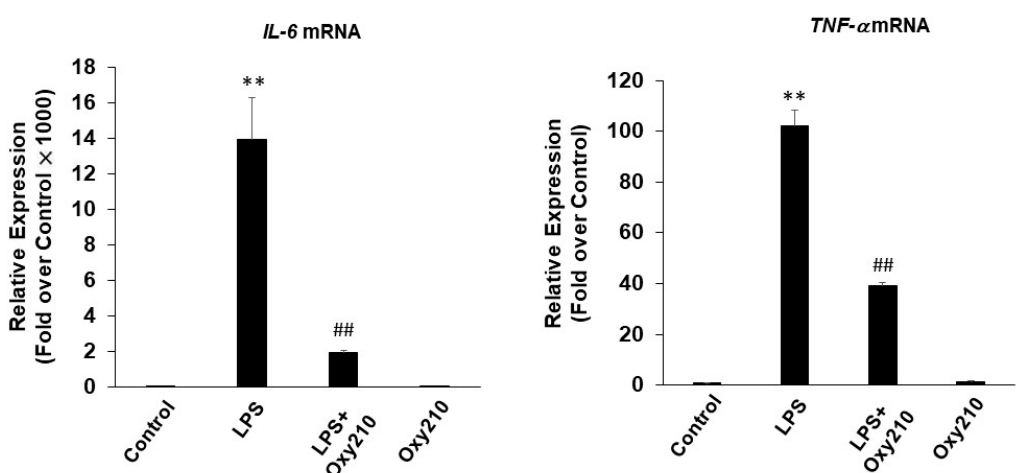
followed by the addition of LPS (25 ng/mL) in the absence or presence of Oxy210 (5 µ M). The 5 µ M concentration of Oxy210 was optimized for causing maximum inhibitory effects on all outcomes mea- sured. After 24 h, RNA was extracted and analyzed by Q-RT-PCR for the expression of inflammatory genes as indicated and normalized to Oaz1 expression. Data from a representative experiment are reported as the mean of triplicate determinations ± SD (** p < 0.01 vs. control; ## p < 0.01 vs. LPS). Table 1. Inhibition of inflammatory cytokine expression by Oxy210 in RAW264.7 macrophages. Cells were pretreated for 24 h with serial dilutions of Oxy210 (0.5, 1, 2.5, 5, 10 µ M) in DMEM containing 0.1% FBS followed by the addition of LPS (25 ng/mL) in the absence or presence of Oxy210 at the same concentrations as that used in pretreatment. After 24 h, RNA was extracted and analyzed by Q-RT-PCR for the expression of the inflammatory genes as indicated and normalized to Oaz1 expression. IC 50 values for the inhibition of each gene from a representative experiment are reported as the mean of triplicate determinations ± SD. Gene IL-6